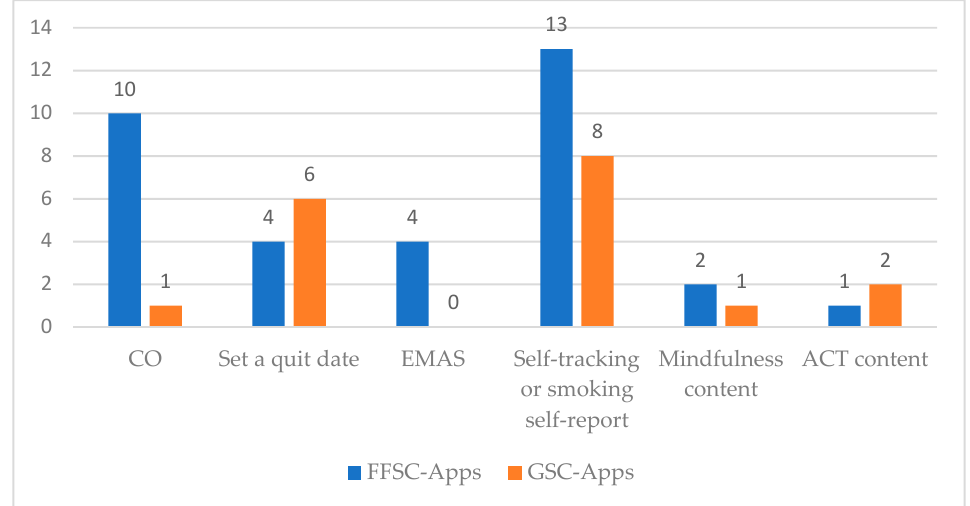
Figure 3. Features of FFSC-Apps and GSC-Apps. CO carbon monoxide, EMAS ecological momentary assessment, ACT acceptance and commitment therapy, FFSC-Apps smoking cessation smartphone apps combined with face-to-face intervention, GSC-Apps general smartphone apps for smoking cessation without face-to-face contact.